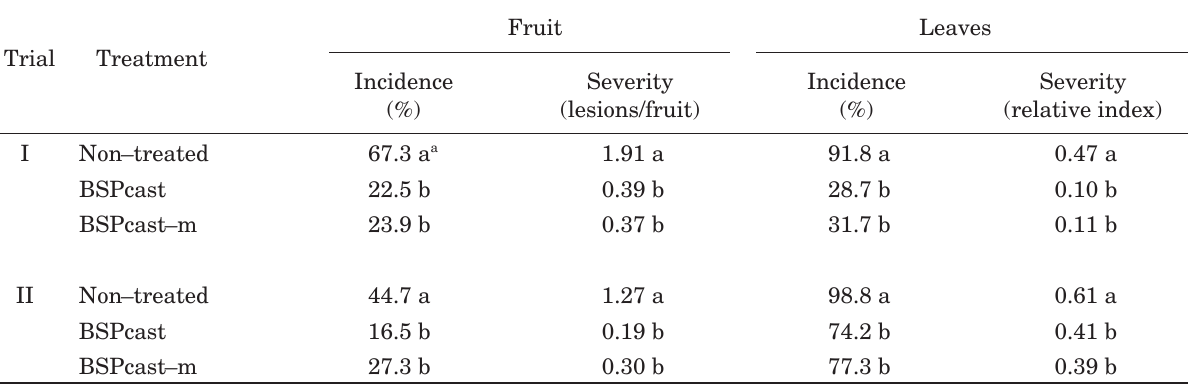
Table 3. Effect of different treatments scheduled by BSPcast or BSPcast-m on incidence and severity on fruit and leaves at harvest for two field